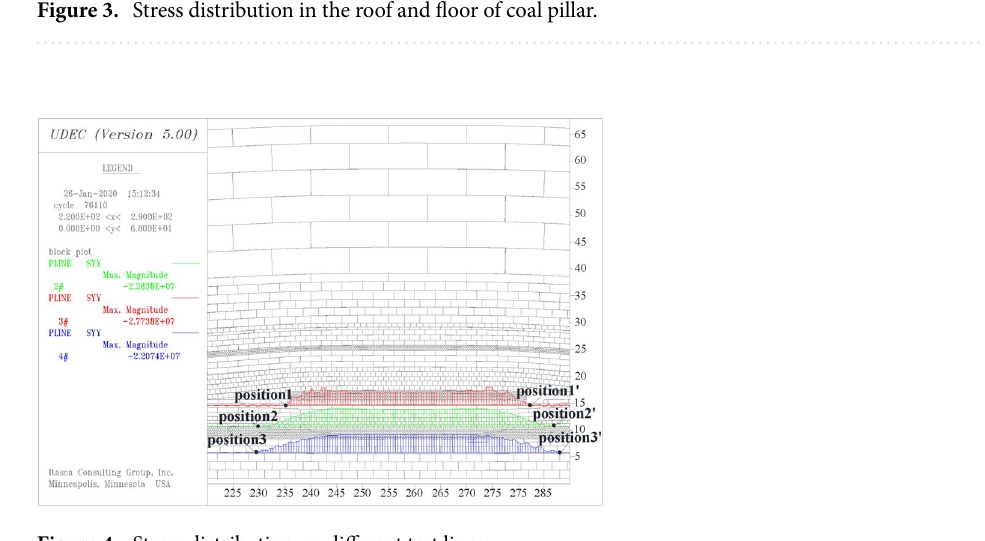
Figure 4. Stress distribution on different test